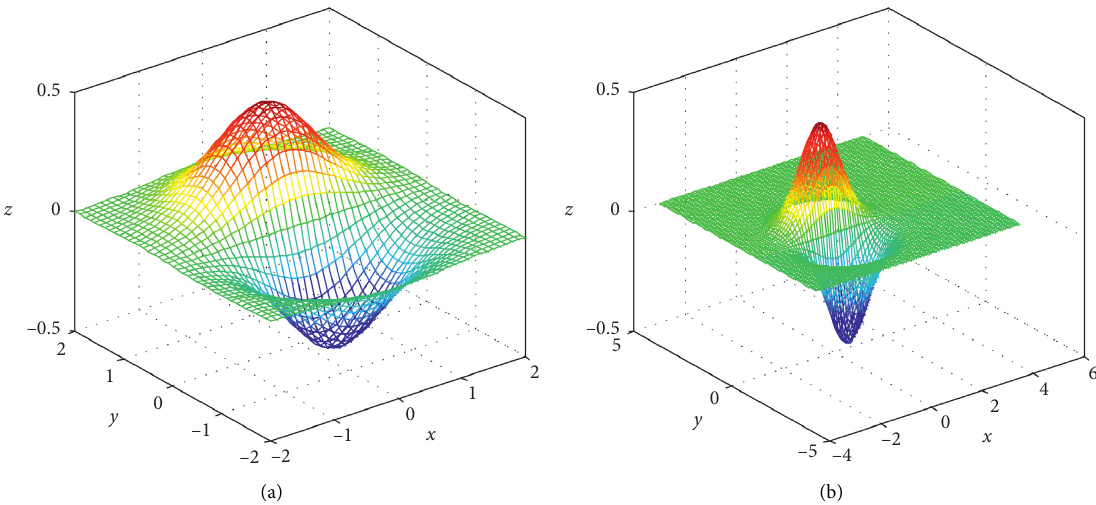
Figure 12: 3D visualization global map of surface in subsidence area.